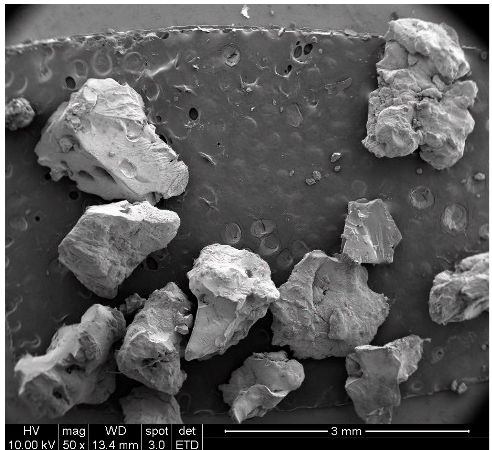
Figure 2. SEM image of PAM (50×).